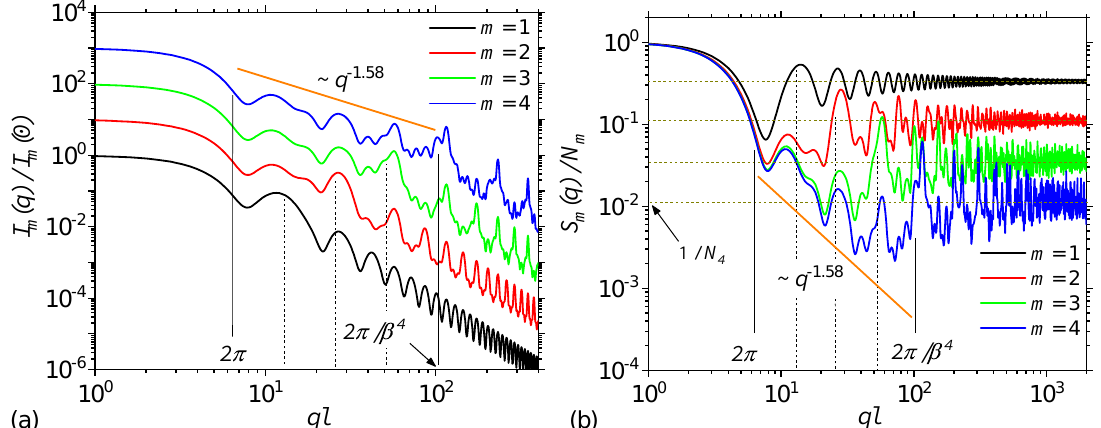
Figure 3. Form ( a ) and structure factors ( b ) of Sierpi´nski triangle (ST) at first four iterations. For the form factor, the curves corresponding to m (cid:54) = 1 are shifted vertically, for clarity, by a factor of 10 m − 1 . The continuous vertical lines denote the beginning and respectively the end of the fractal region at m = 4. The dashed vertical lines denote the end of the fractal region at iterations m = 1,2 and 3. l is the overall size of the ST, β = 1/2 is the scaling factor, and N 4 = 3 4 is the number of triangles composing the ST at m =